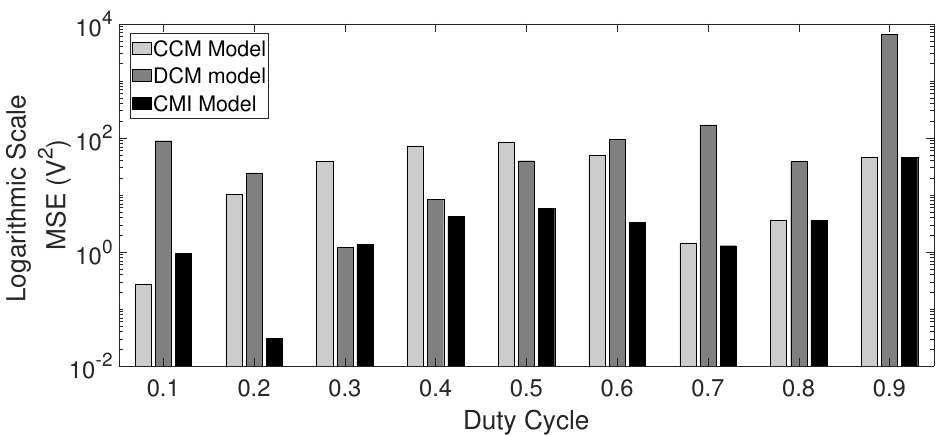
Figure 7. Voltage mean-squared error for CCM, DCM, and CMI models, in logarithmic scale. The CMI model presented in this paper provides the lowest MSE in almost all the u 1 range.